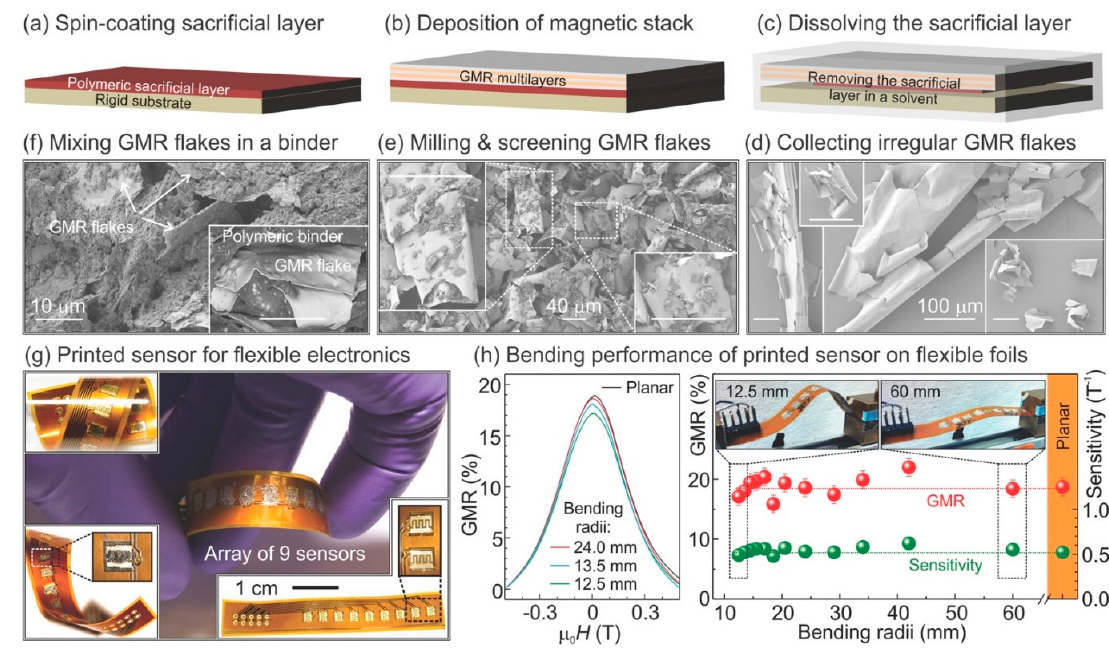
Figure 17. ( a – f ) Schematic illustration of the fabrication process of the GMR flakes; ( g ) printed GMR sensor arrays on flexible substrate; ( h ) evolution of magnetoelectrical performance of the printed GMR sensors upon different bending radius [151]. Reprinted under the terms of the Creative Commons Attribution Non ‐ Commercial License.